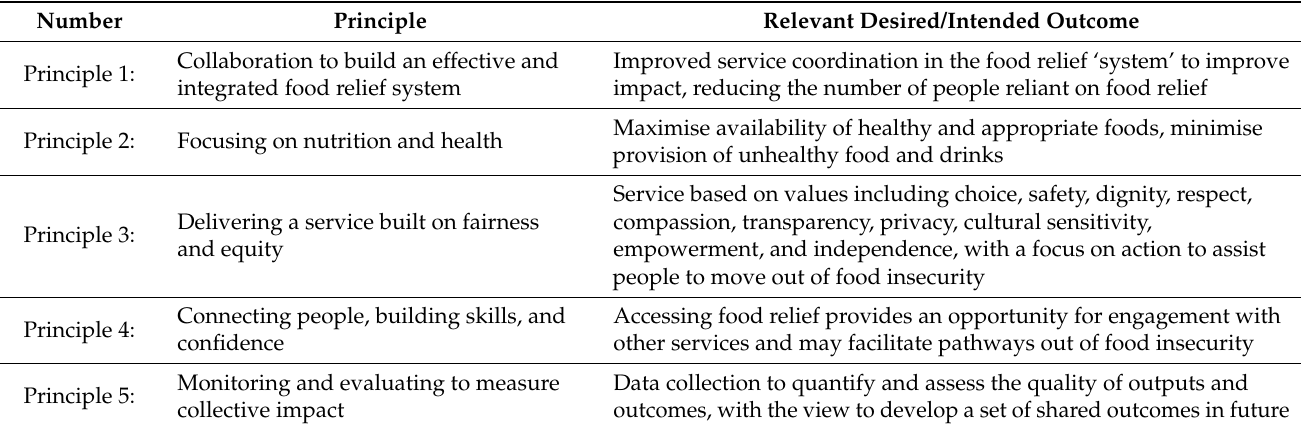
Table 2. Summary of the Guiding Principles of the South Australian Food Relief